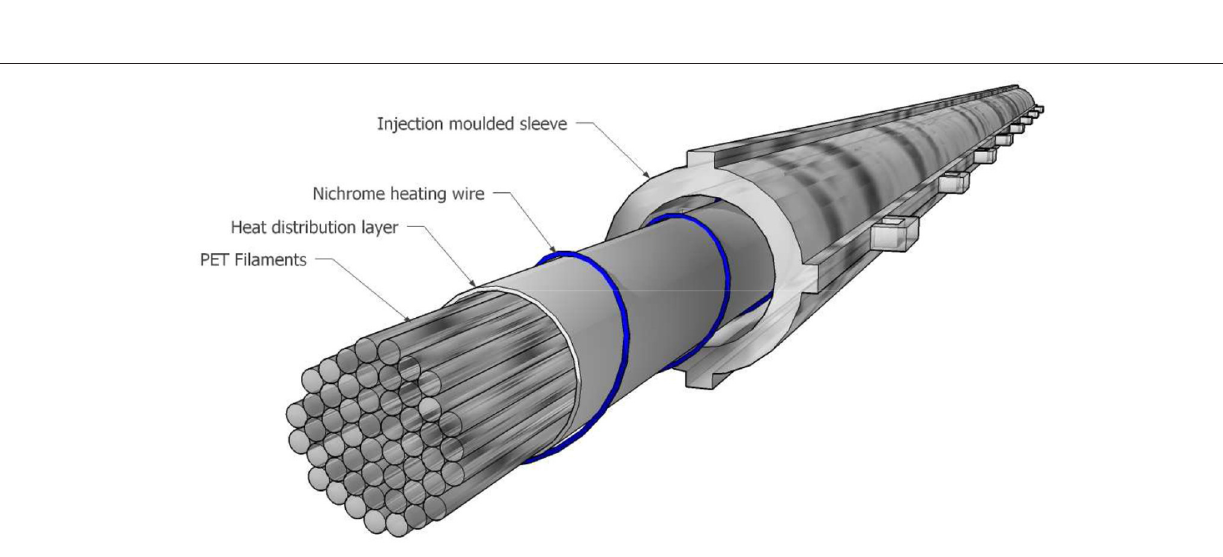
FIGURE 5 | Shape memory PET tendon crack closure system (Teall et al.,